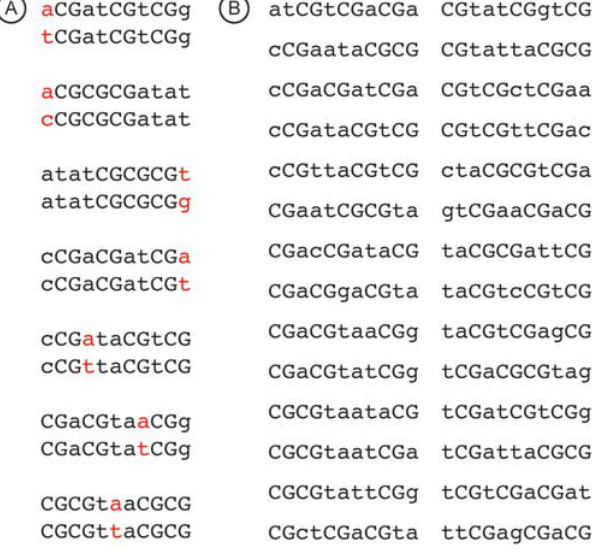
Table 1. Proponderance of CpG dinucleotides in the